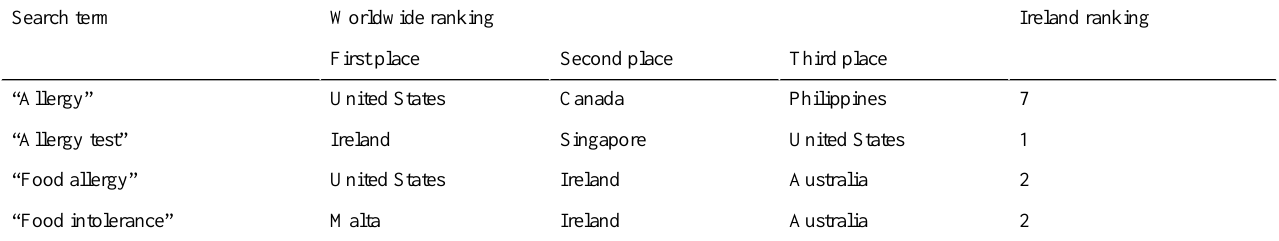
Table 1. Google Trends January 1, 2009, to December 31, 2018, worldwide for the specified search terms.